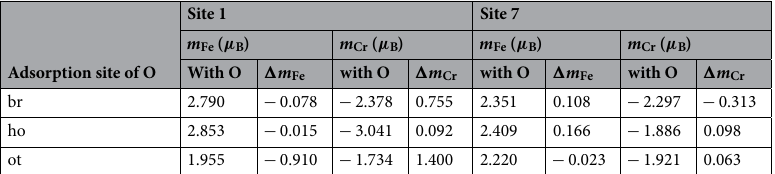
Table 3. Magnetic moments at atomic sites 1 and 7 (see Fig. 1) in the dilute-limit Fe–Cr alloy with one Cr atom in the first or second surface layer. The Fe moments are averaged over Cr configurations with Cr in the nearest- or next-nearest-neighbour position to Fe. The magnetic moments ( m ) of Fe and Cr are shown with O adsorbed at either the bridge (‘br’), hollow (‘ho’) or on-top (‘ot’) site. The effect of the adsorbed O is measured by the difference � m X = m X ( with O ) − m X ( without O ) , where X = Fe or Cr. The magnetic moments without adsorbed O are m Fe = 2.868 µ B and m Cr = − 3.133 µ B at site 1 and m Fe = 2.243 µ B and m Cr = − 1.984 µ B